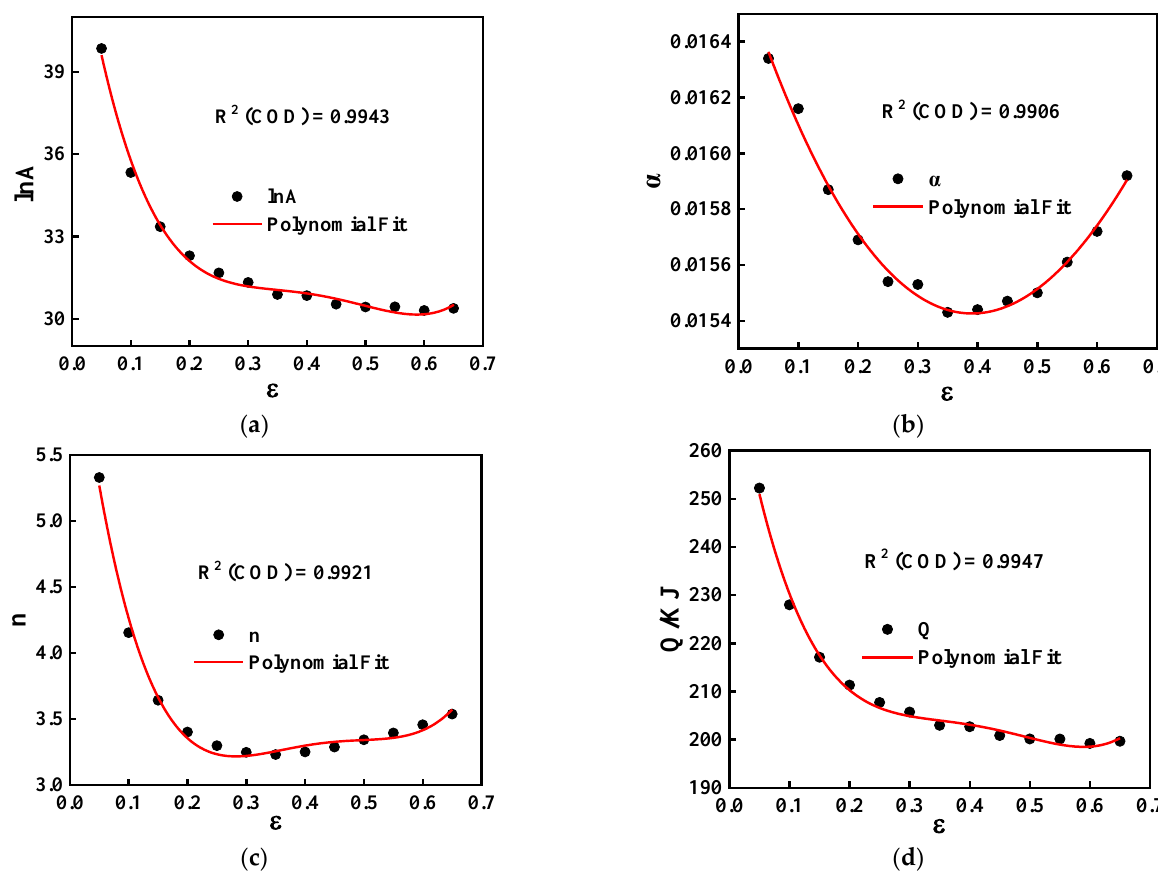
Figure 6. Relationship between ln Z and ln [ sinh ( ασ )] .